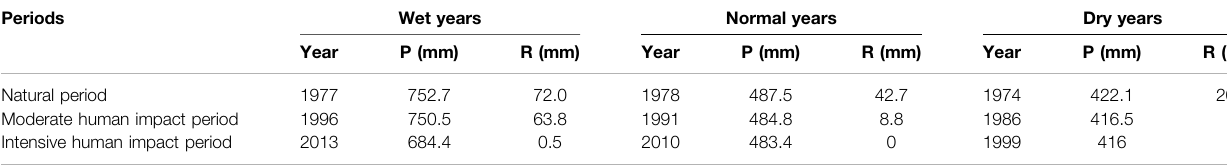
TABLE 2 | Hydrological element information of typical years in different periods.